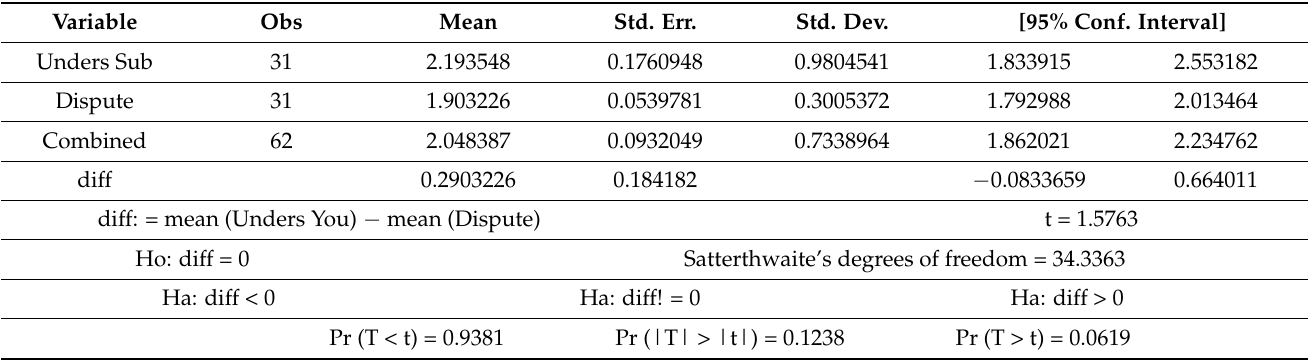
Table 1. Superiors’ understanding of the PMDS and your involvement in a PMDS dispute (round